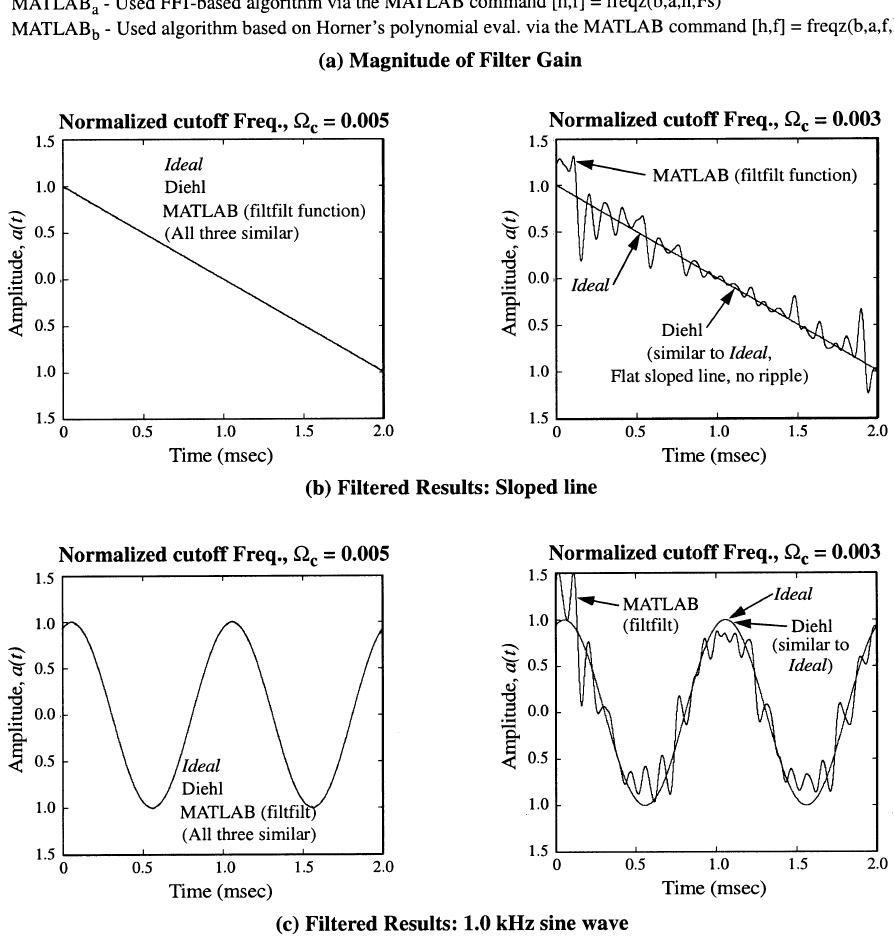
Fig. 1. Comparing MATLAB lowpass filtering and Diehl’s DSP Extensions using some digital test signals. Sample rate of all signals is 6 MHz. are a sloped line and three sine waves with frequencies ideal solution, results from ABAQUS/Post, and results of 1.3 kHz, 6.0 kHz, and 29.0 kHz (note that the sine from Diehl’s DSP Extensions. ABAQUS/Post uses a waves are defined such that they begin with non-zero single-pass sine-Butterworth IIR filter (a slight varia- amplitude). The curves depicted in (b)–(e) show the tion on the more common Butterworth filter) with